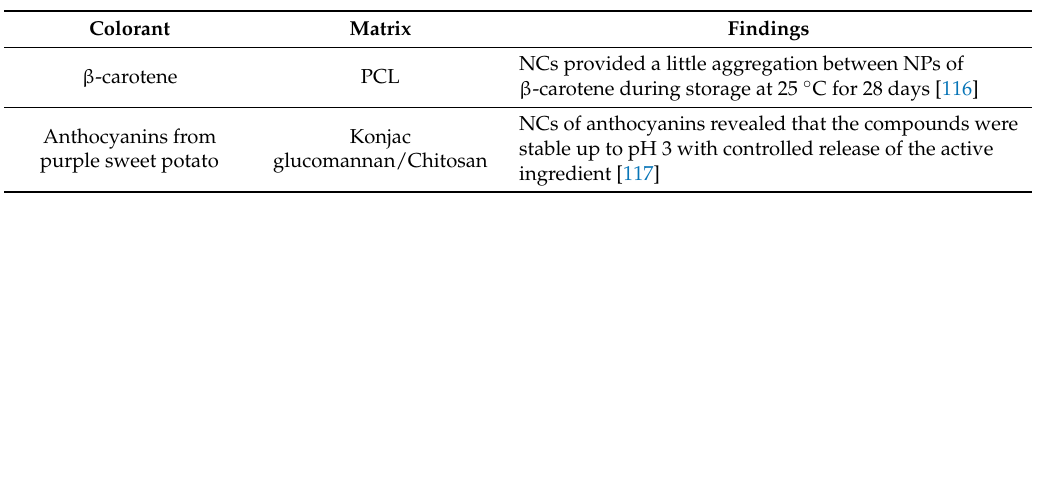
Table 4. Recent studies of nanostructured matrix containing